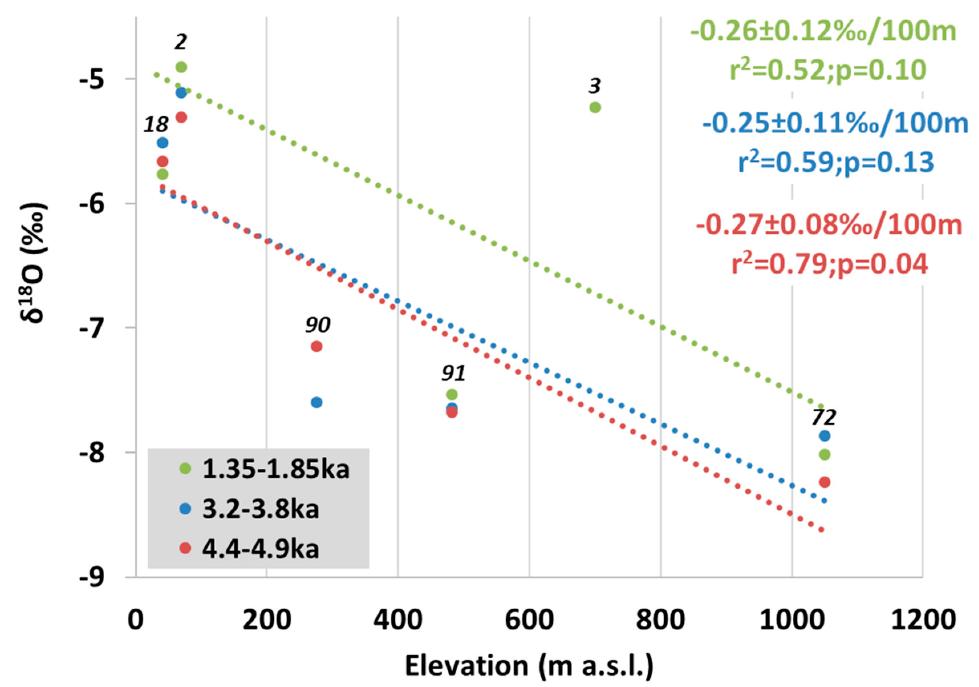
Figure 6. Elevation gradient of δ 18 O spel for three semi-millennial time horizons for the past 5000 yrs for SE Europe. The italic numbers above the dots refer to the site names found in Table 1.